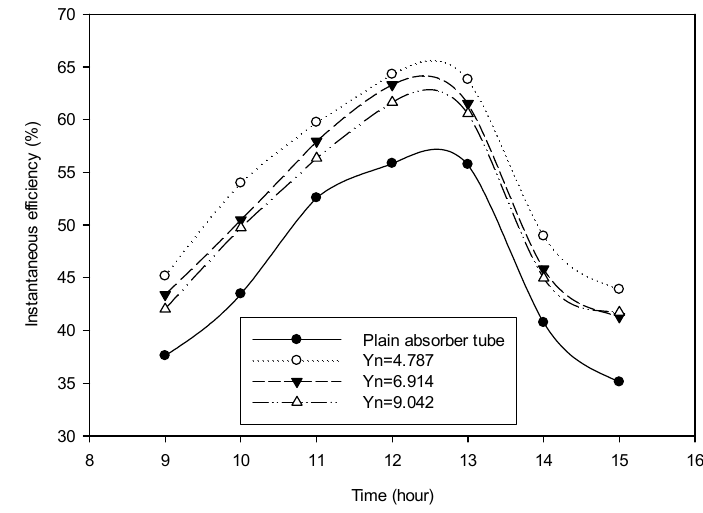
Figure 12. Variation in instantaneous efficiency with time and nail twist pitch ratio.